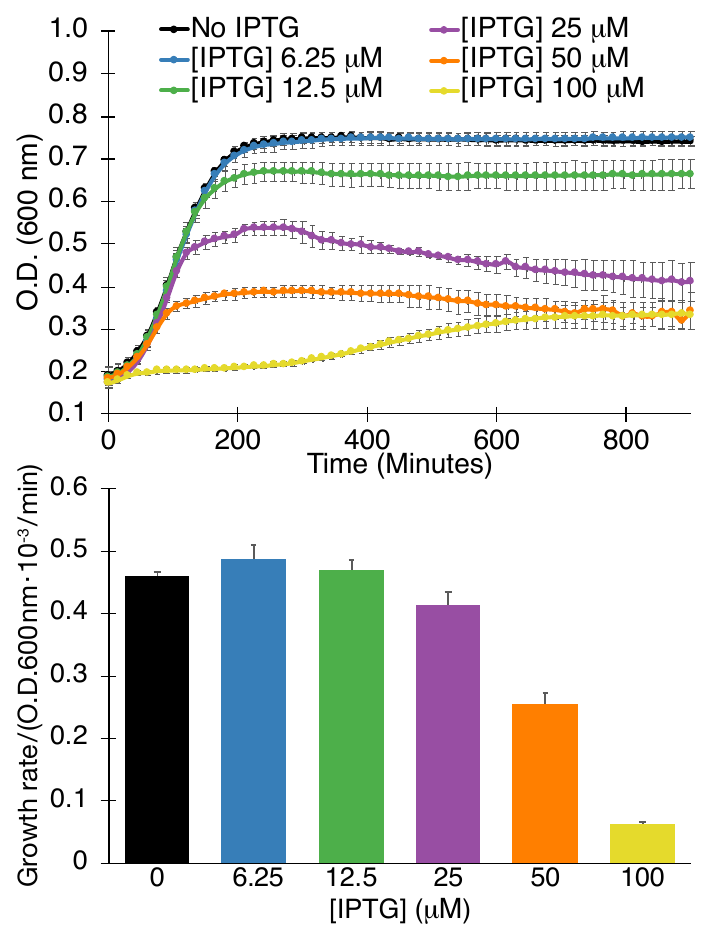
Figure 1. Negative assay. Growth curves ( top ) and maximal growth rates ( bottom ) of bacteria as a function of SARS-CoV 3a protein expression, governed by the level of the inducer β - D -1- thiogalactopyranoside (IPTG), as indicated. The analyses were performed in triplicates with indicated standard